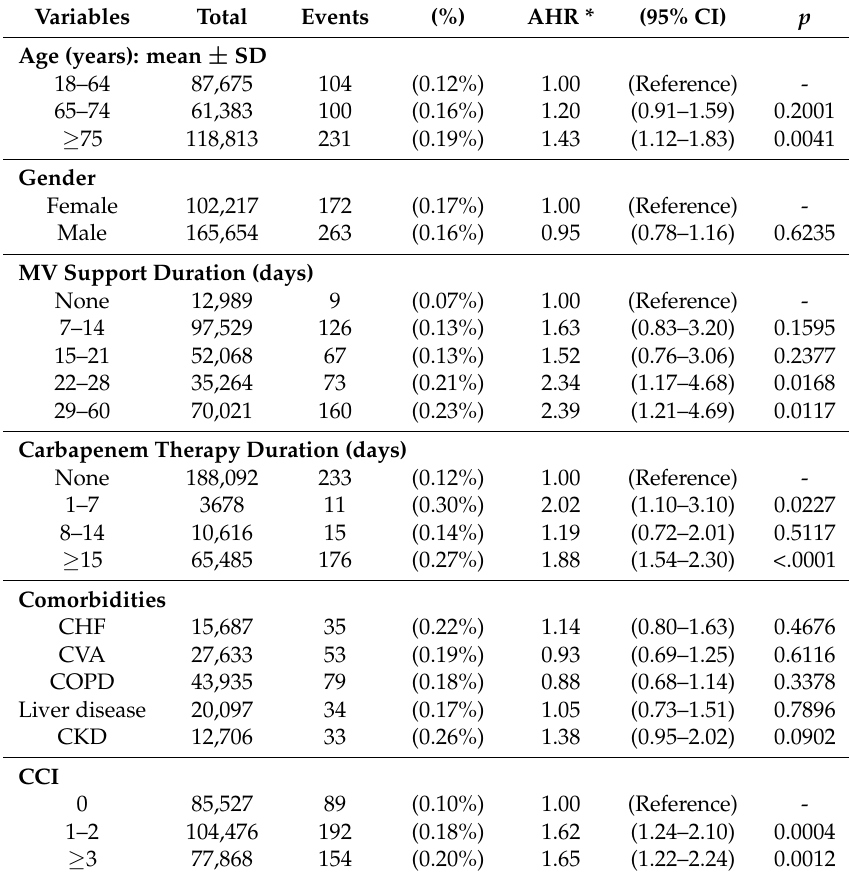
Table 2. Multivariate analysis for C. difficile infection in intubated ICU